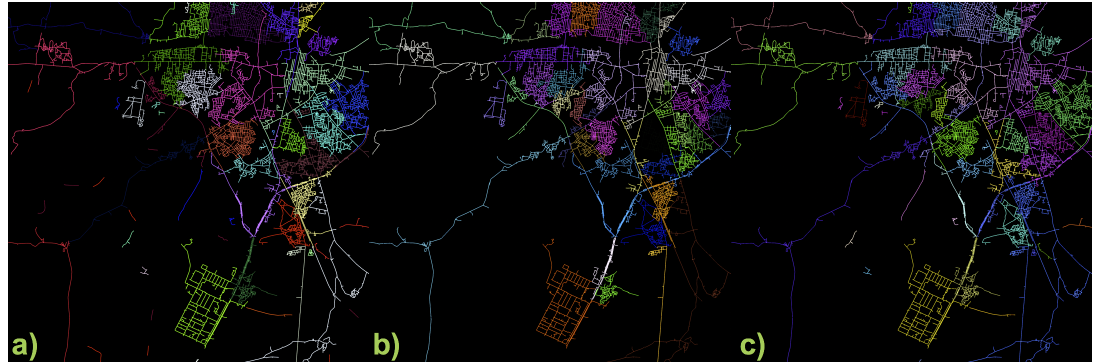
Figure 7. Comparison of Region Creation Methods. Experiments with ( a ) normalized min-cut-; ( b ) Newman–Girvan-; and ( c ) modularity-based partitioning of the road graph.